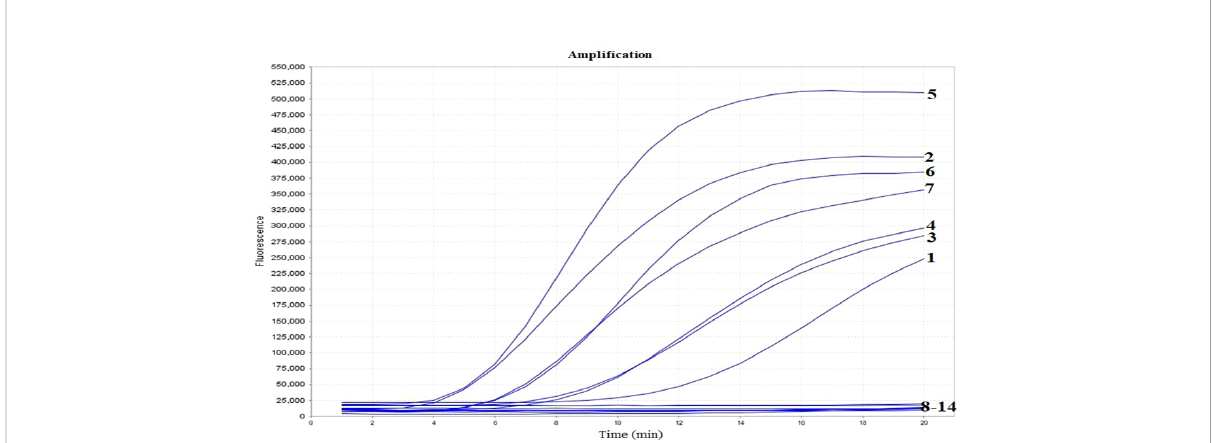
FIGURE 3 Speci fi city of the real-time RT-RAA assay. Curves 1-14, nucleic acid templates corresponding to H1N1, H3N2, H5N1, H5N6, H7N9, H9N2, H11N3, IBV-V, IBV-Y, ICV, RSV-A, RSV-B, SARS-CoV-2 and negative control,